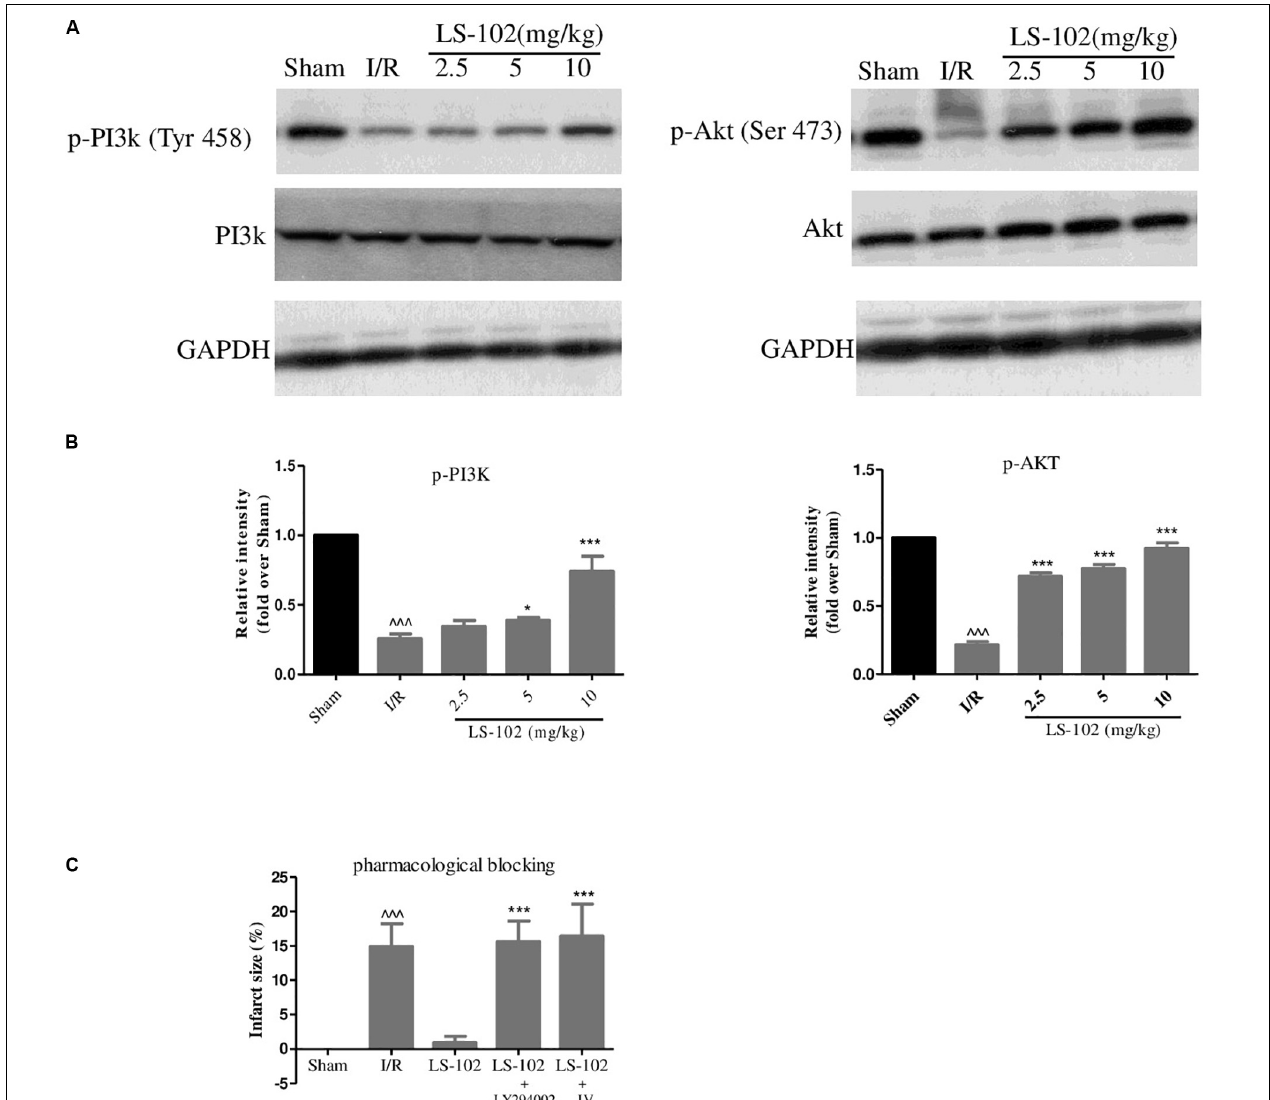
FIGURE 3 | Effect of LS-102 on the PI3K/ Akt signaling in rat heart. (A) Representative Western blot of total and phosphorylated PI3K and Akt. (B) Quantitative analysis of band intensity, values are expressed as mean ± S.E.M. of 4 hearts from each group. (C) Infarct size of a rat after the pharmacological blockage of PI3K and Akt. Sham and I/R, distilled water 8 ml/kg; LS-102, LS-102 10 mg/kg; LS-102+LY294002, LS-102 10 mg/kg+ PI3K inhibitor LY294002 0.25 mg/kg; LS-102+ IV, LS-102 10 mg/kg+Akt inhibitor IV 4mg/kg. Vehicle or LS-102 was given to rats 30 min before LAD ligation. Pharmacological inhibitors were given immediately after the administration of LS-102. Values are mean ± SEM of six rats from each group. ˆˆˆ P < 0.001, vs Sham group; * P < 0.05, *** P < 0.001, vs I/R